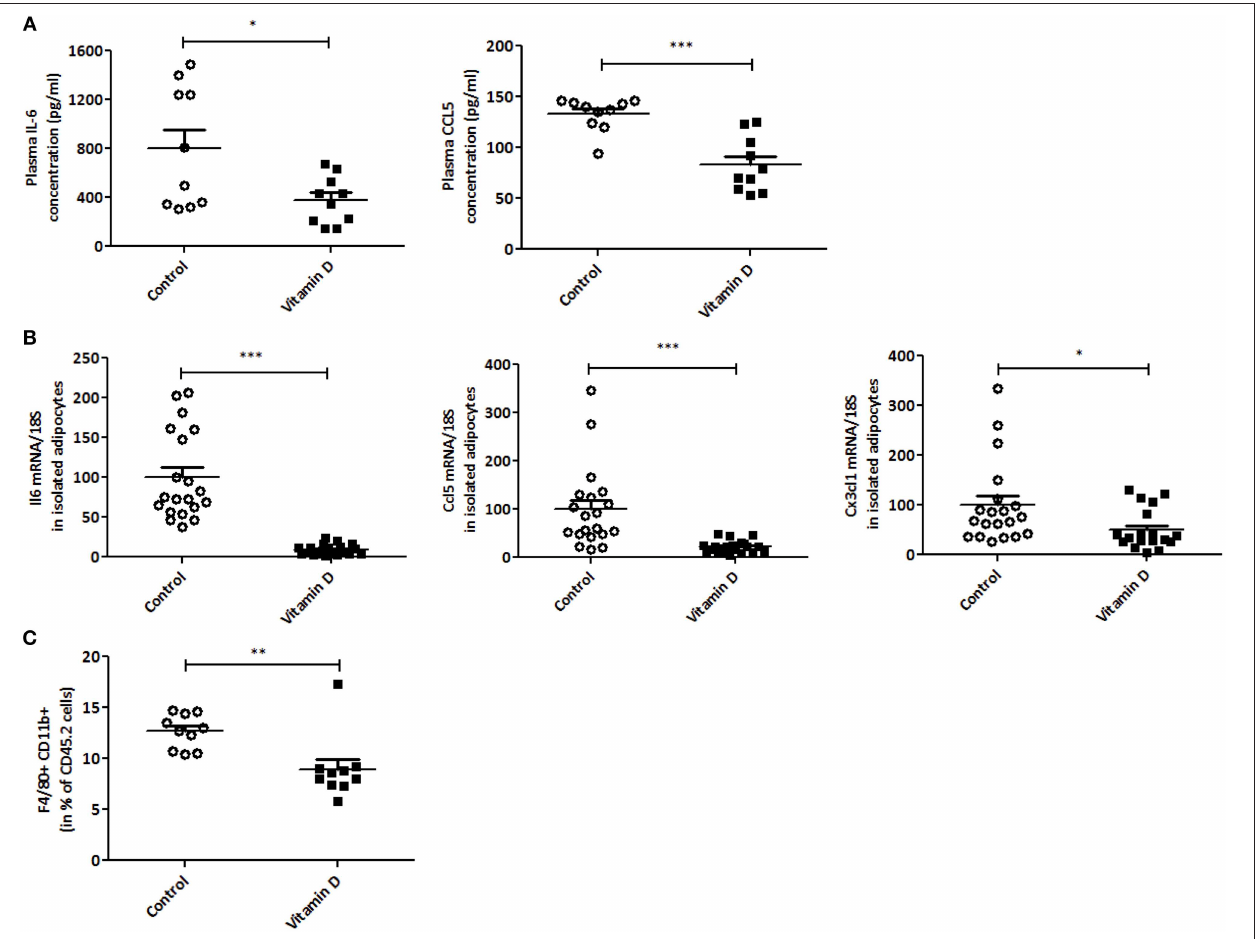
FIGURE 3 | Vitamin D limits inflammation in plasma, adipocytes and stromal vascular fraction of mice. (A) In EO771 breast cancer model (Standard diet), inflammatory cytokines (IL-6 and CCL5) levels were measured in plasma by ELISA ( n = 8–10). (B) mRNA levels of Il6, Ccl5 and Cx3cl1 were quantified through qPCR in isolated adipocytes from visceral adipose tissue ( n = 10) and expressed relative to 18S ribosomal RNA. The data are expressed as relative expression ratios. (C) Inflammatory macrophages (F4/80 + CD11b + ) were quantified in stromal vascular fraction of adipose tissue ( n = 8–10) by flow cytometry. The values are presented as the mean ± SEM. * P < 0.05, ** P < 0.01, *** P < 0.001 compared with control